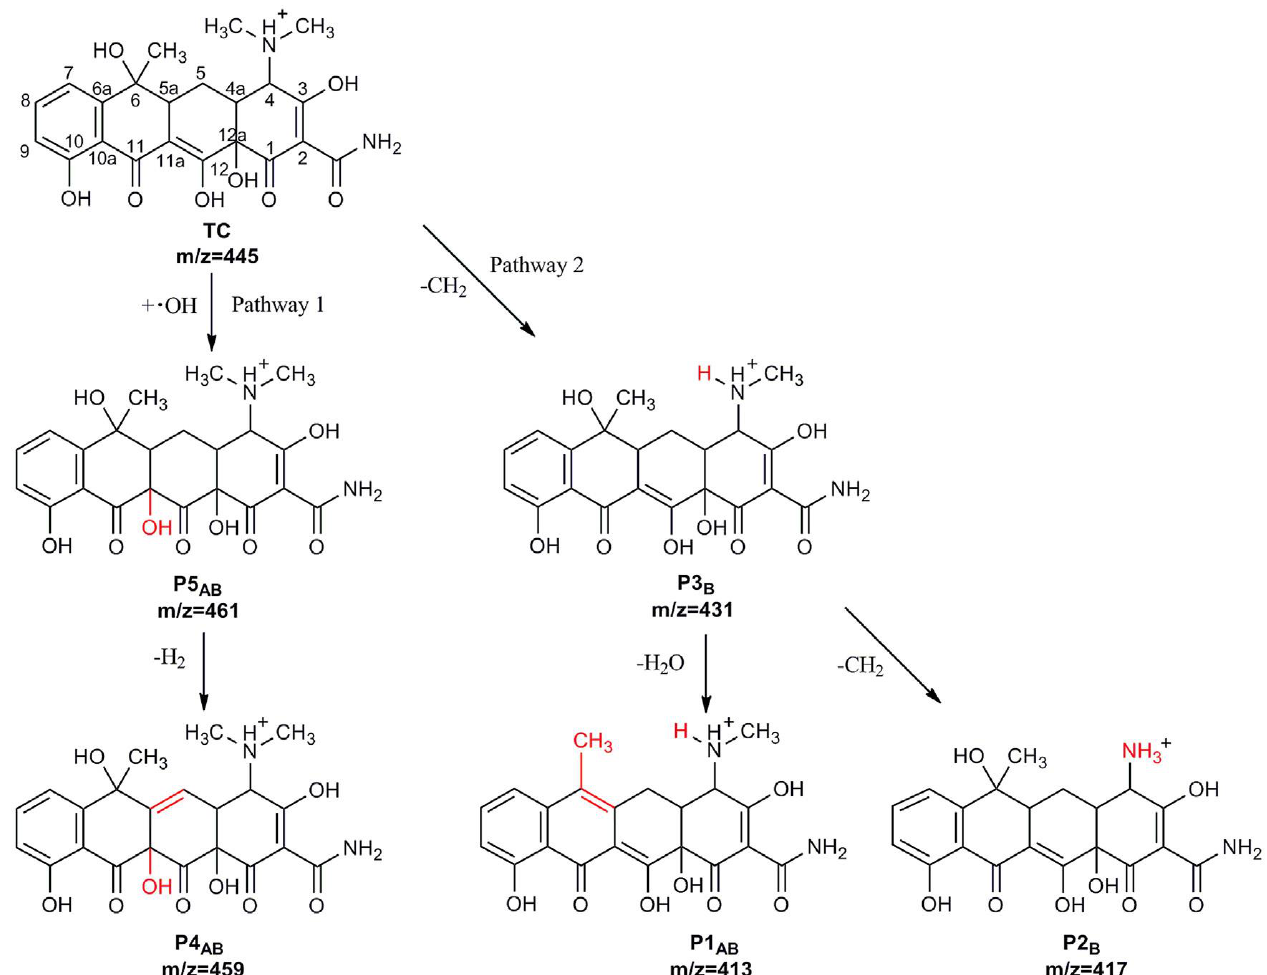
Figure 11. A proposed tetracycline degradation mechanism. The structures of these intermediates were suggested based on their retention time, the fragmentation pattern from the mass spectra and from structures suggested by other studies. There are two pathways of degradation based on the intermediate degradants. In the first pathway, two intermediates are produced, where P5 was produced by the addition of an OH radical to the C11a-C12 double-bond, which then transforms to P4 by H-abstraction at C5a by hydroxyl radical attack. In the second pathway the first intermediate (P3) was produced by the elimination of -CH 2 , group which either transforms to P1 by dehydration reaction of P2 or by the loss of -CH 2 group. Adapted with permission from [107]. Copyright 2016 Elsevier.